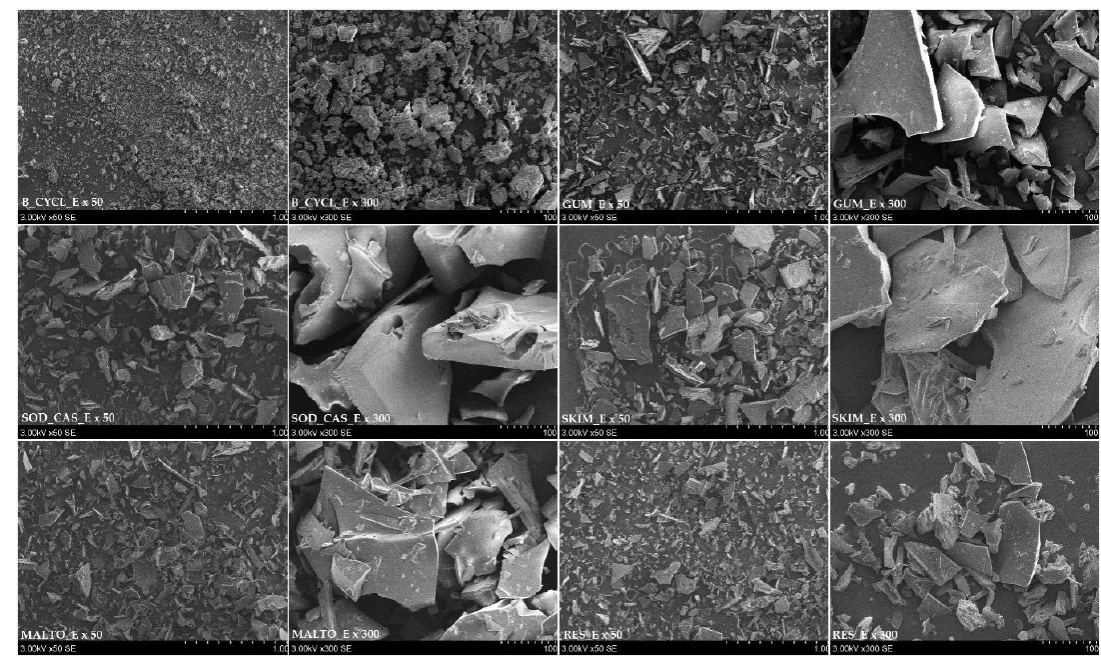
Figure 6. Images of freeze-dried powders obtained using different wall materials and mixtures.